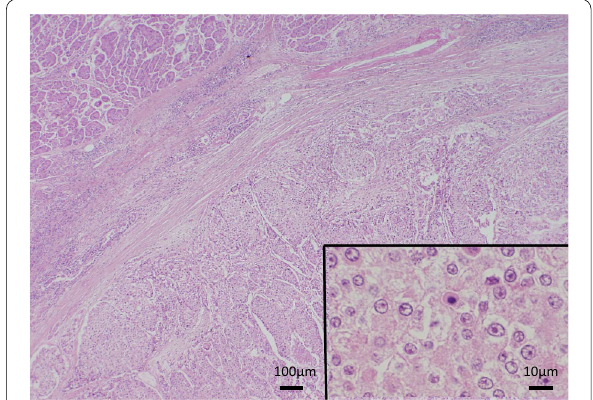
Fig. 3 Histology of left breast cancer. The tumor is composed of large nests with central comedo necrosis. The tumor cells have large round vesicular nuclei, prominent nucleoli, and pale eosinophilic granular cytoplasm